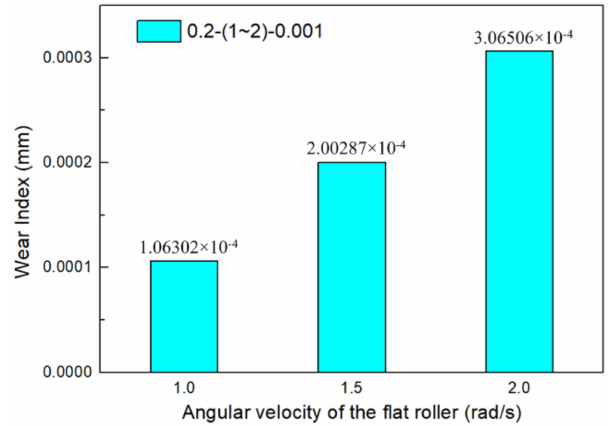
Figure 9. Influence of flat roller angular velocity on wear depth.